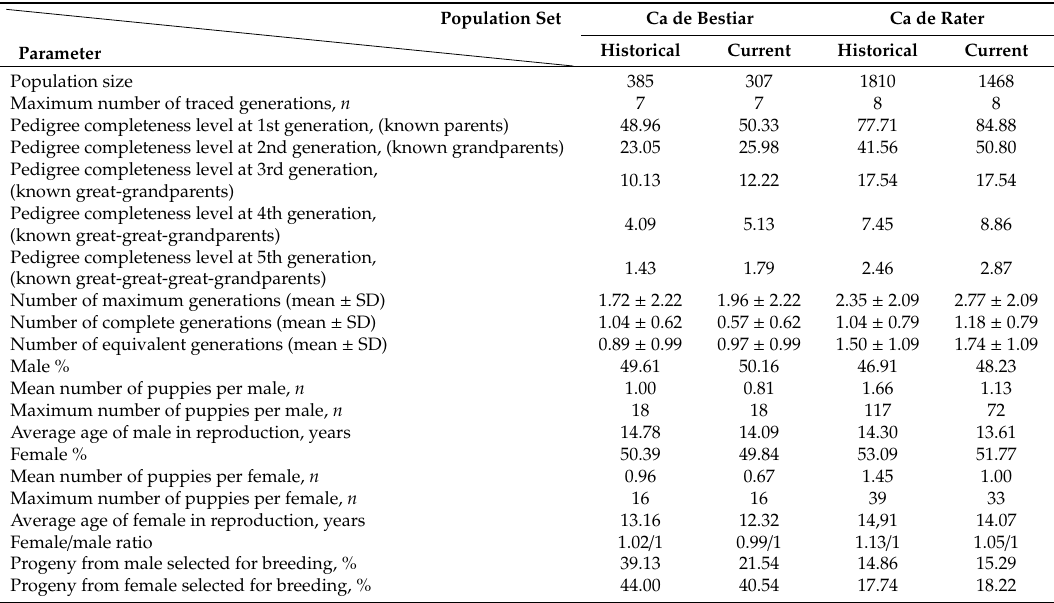
Table 1. Summary of demographic and o ff spring analysis parameters in Ca de Rater and Ca de Bestiar historical and current population